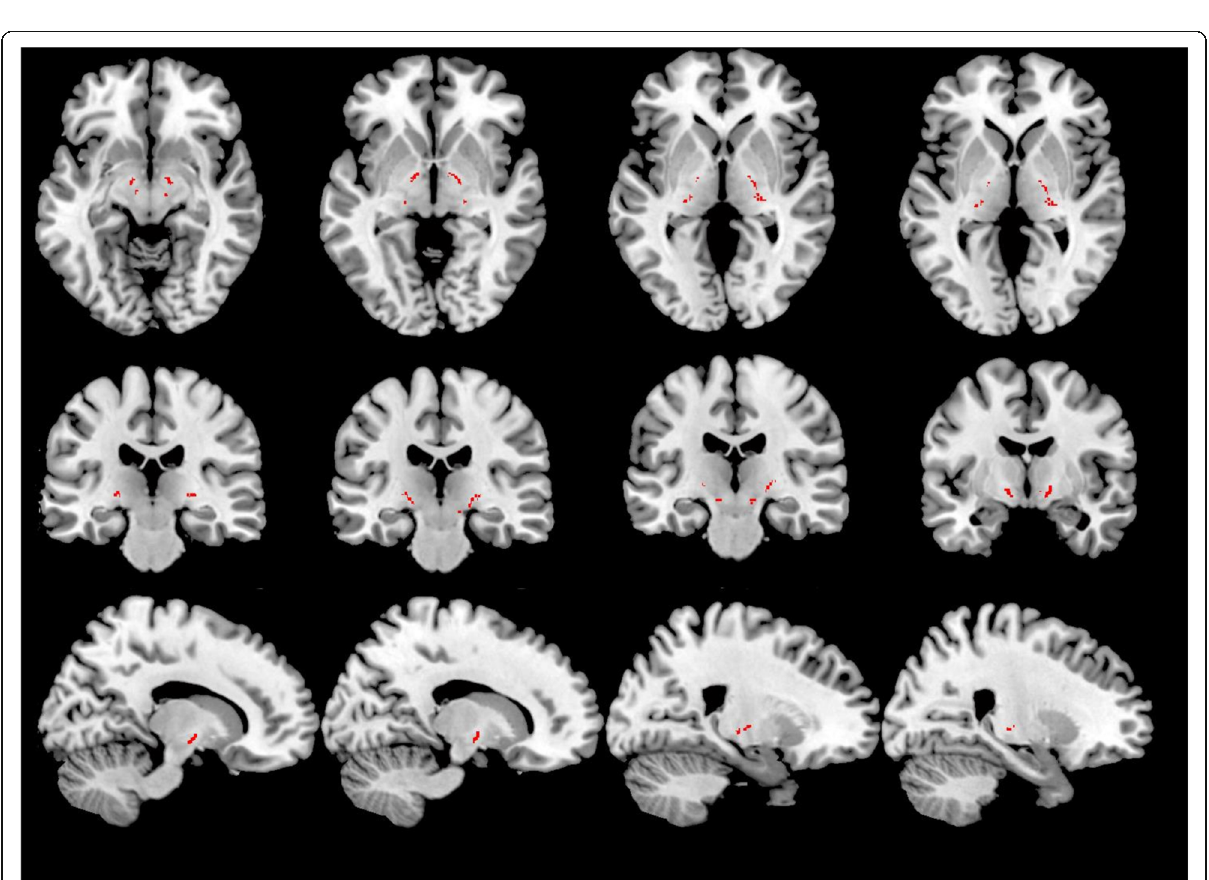
Fig. 2 Left and right nigroputaminal tractography results (in